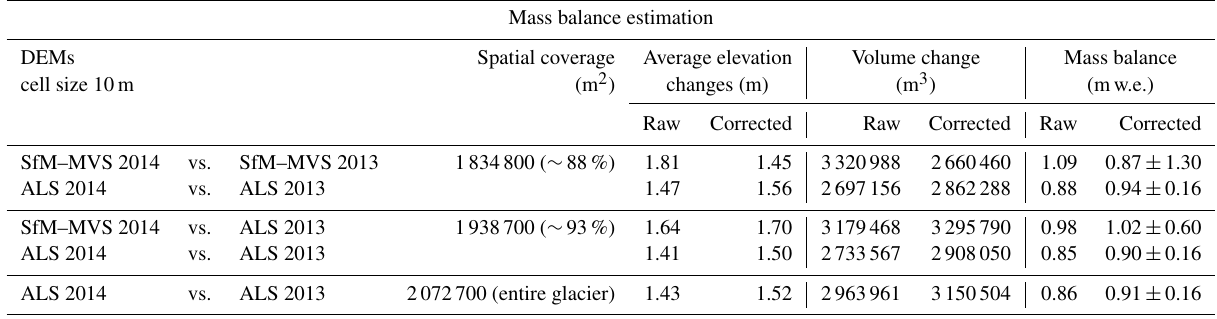
Table 4. Mass balance calculations on La Mare Glacier using different combinations of SfM–MVS and ALS DEMs.